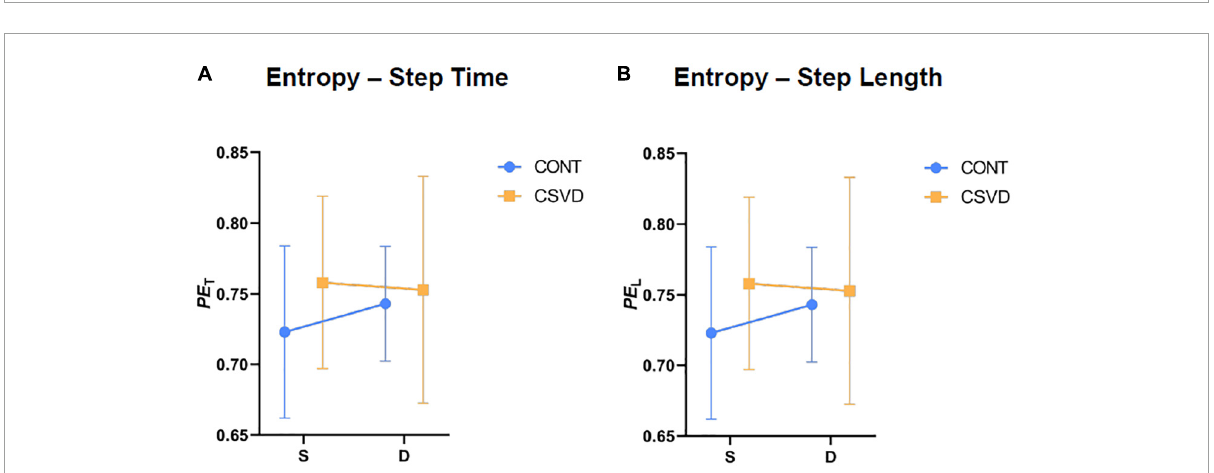
FIGURE4 Entropy of gait pattern is not altered by cerebral small vessel disease (CSVD). Permutation Entropy of Step Time [ PE T , panel (A) ] and Permutation Entropy of Step Length [ PE L , panel (B) ] are statistically similar (two-way RM-ANOVA, p > 0.05) between CSVD ( n = 11; orange square symbols) and age- and sex matched elderly control (CONT, n = 11; light blue circle symbols) groups for both task conditions. Symbol and error bar depicts mean ±